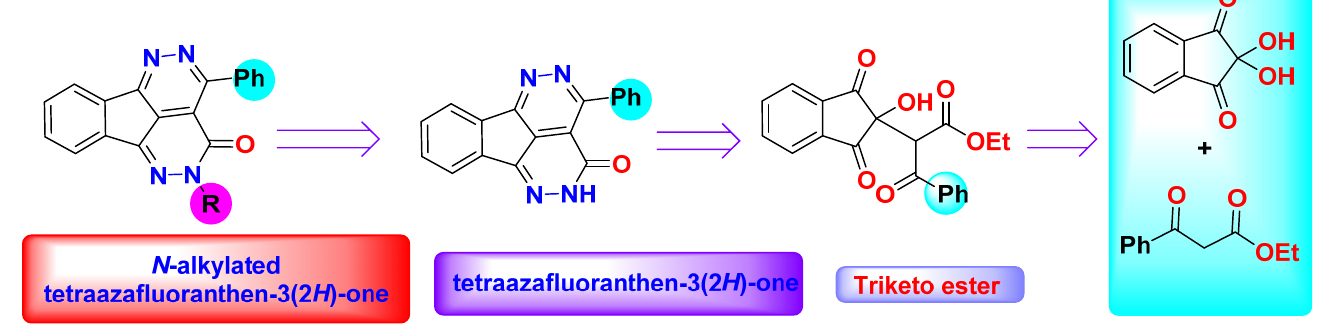
Figure 1. Retro-synthesis of the fluoranthenes.